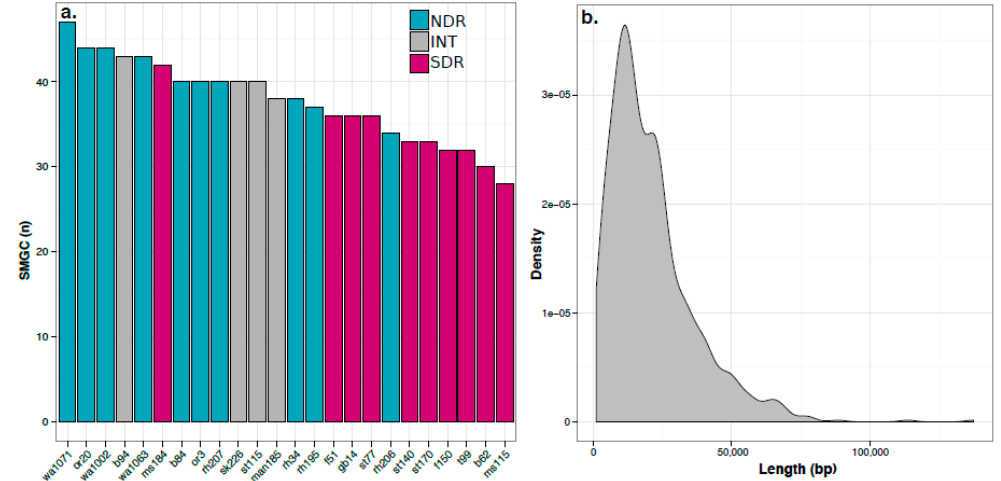
Figure 2. NDR strains have more secondary metabolite biosynthetic gene clusters (SMGCs) than SDR strains ( t -test, p < 0.001). ( a ). Bars indicate the number of SMGCs identified in each genome and are colored according to clade affiliation, and genome names reflect the site of isolation as identified in Table S1; ( b ). Kernal density plot shows the distribution of SMGC length (bp). Only 21% ( n = 25) of the MIBiG-annotated SMGCs represent well-characterized biosynthetic gene clusters (in which ≥ 70% of the genes in a SMGC show similarity to genes within the most similar known cluster from the MIBiG database) (Table S3). In addition, each genome harbors five to 25 potentially novel SMGCs with low similarity to biosynthetic pathways within the MIBiG database.